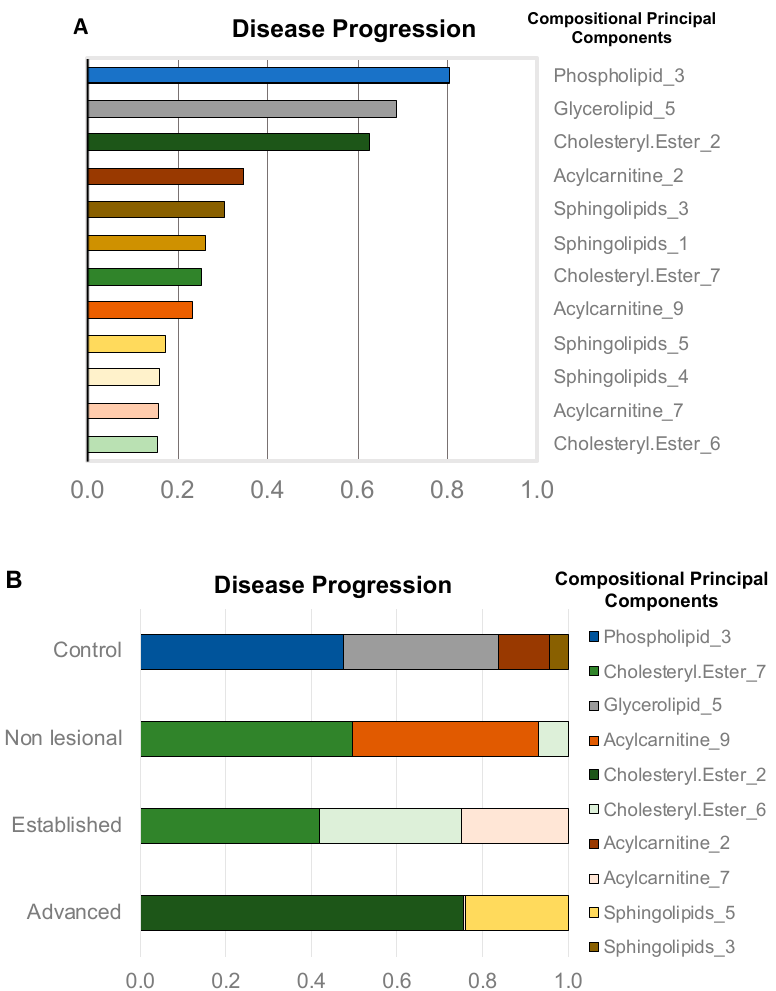
Figure 4. Importance of compressed categories for disease progression classification. ( A ) univariate linear model—selected lipid categories CPC based on their effect size (n 2 ). ( B ) contribution of the top 10 CPC to the classification of disease progression categories by the multivariate elastic net model with an accuracy of 81%.